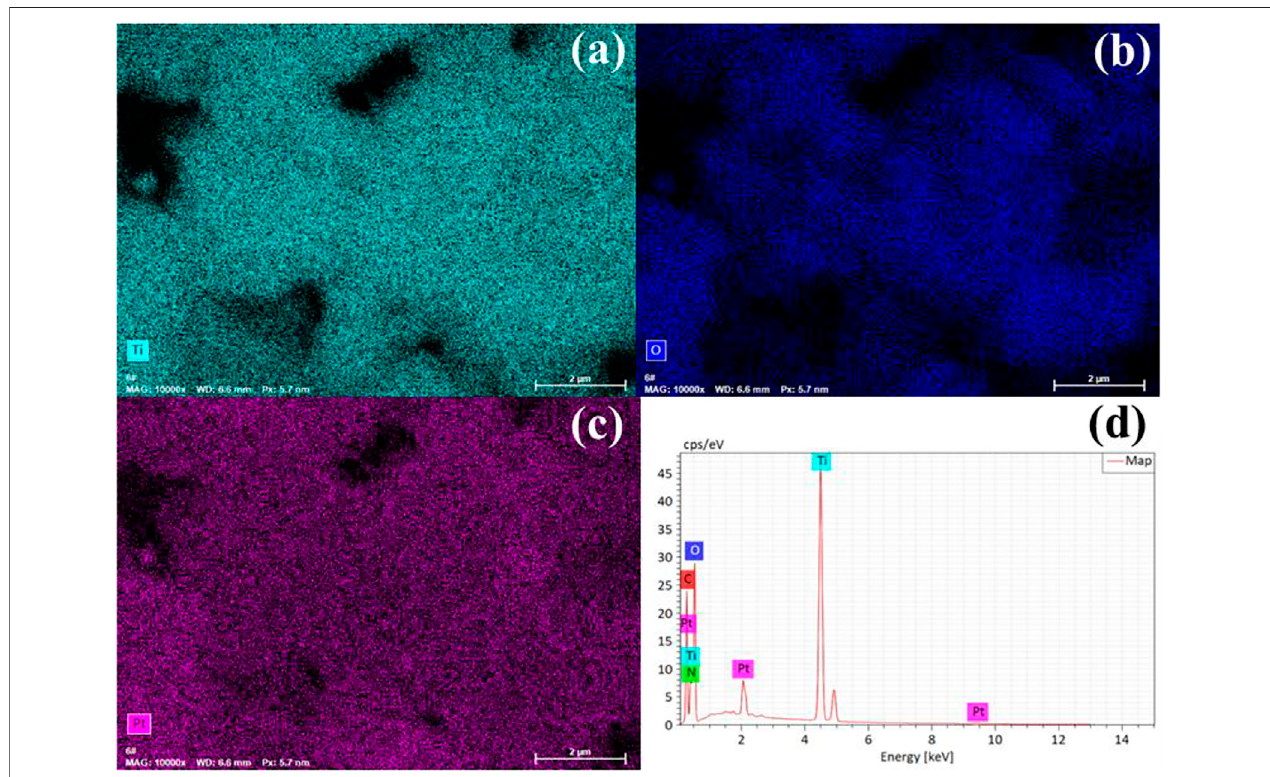
FIGURE 2 | EDS mapping of elements Ti (A) , O (B) , Pt (C) , and elements composition (D) of TNT-400-Pt.